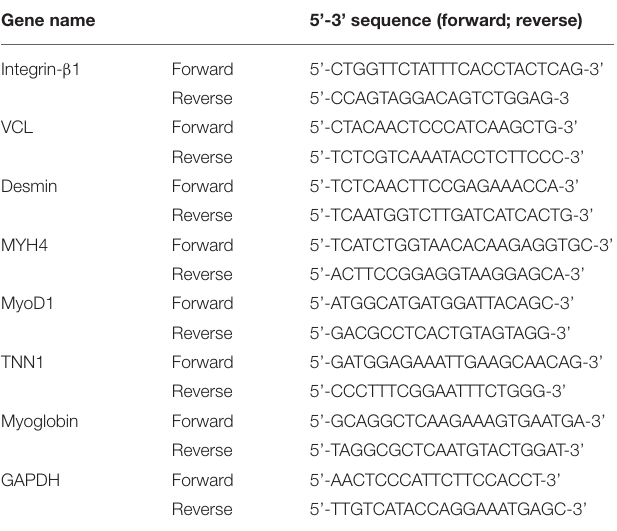
TABLE 1 | Primers for the target gene.